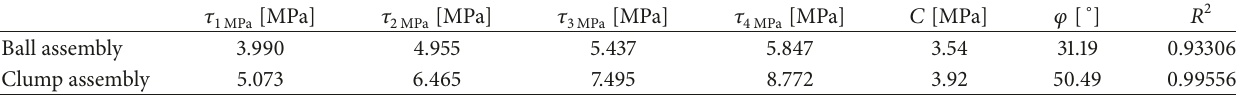
Table 5: Results of the linear